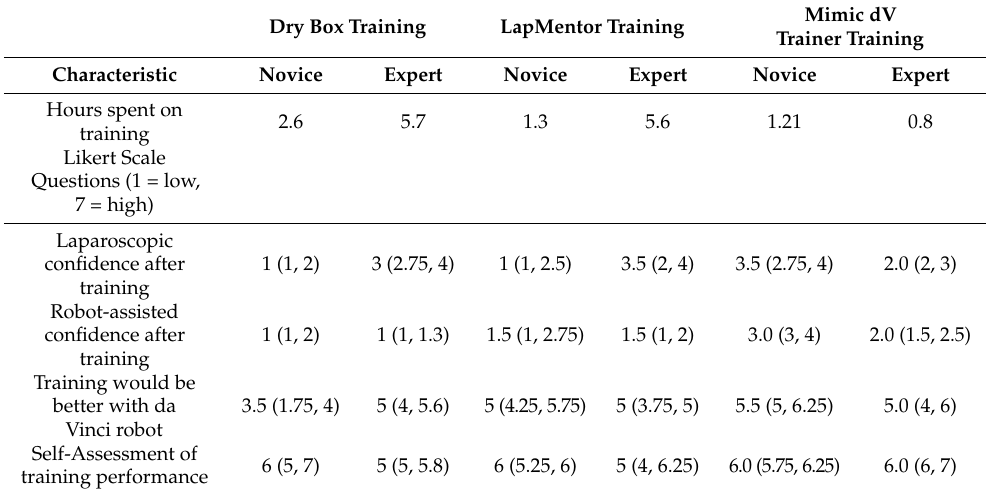
Table 3. Survey after training session (Self-Assessment